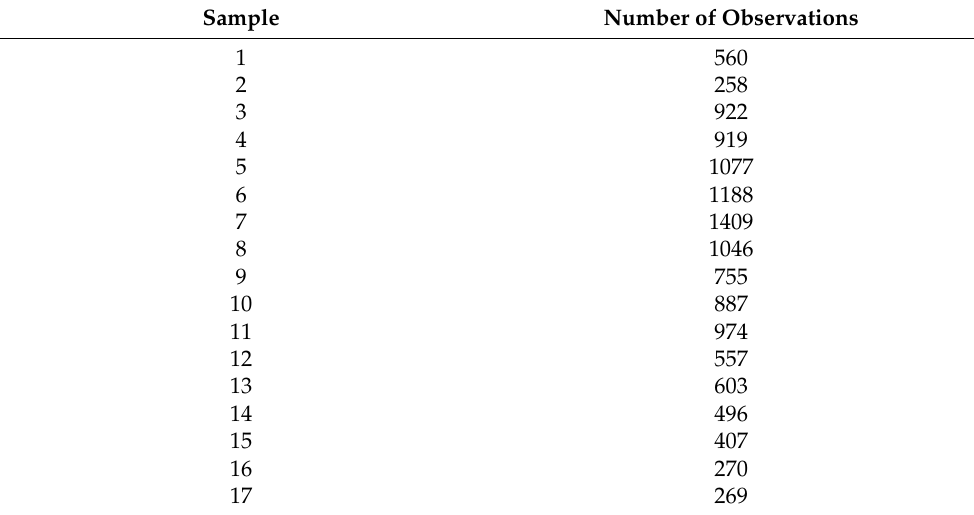
Table 2. Characteristics of the datasets used in the third case study.